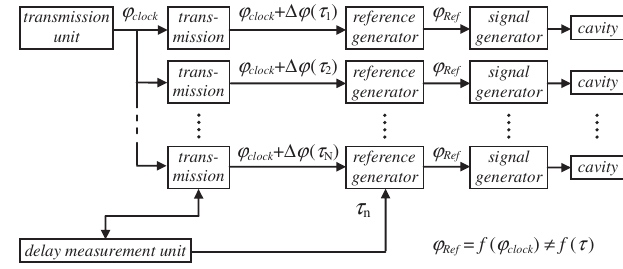
FIG. 3. Cavity synchronization.